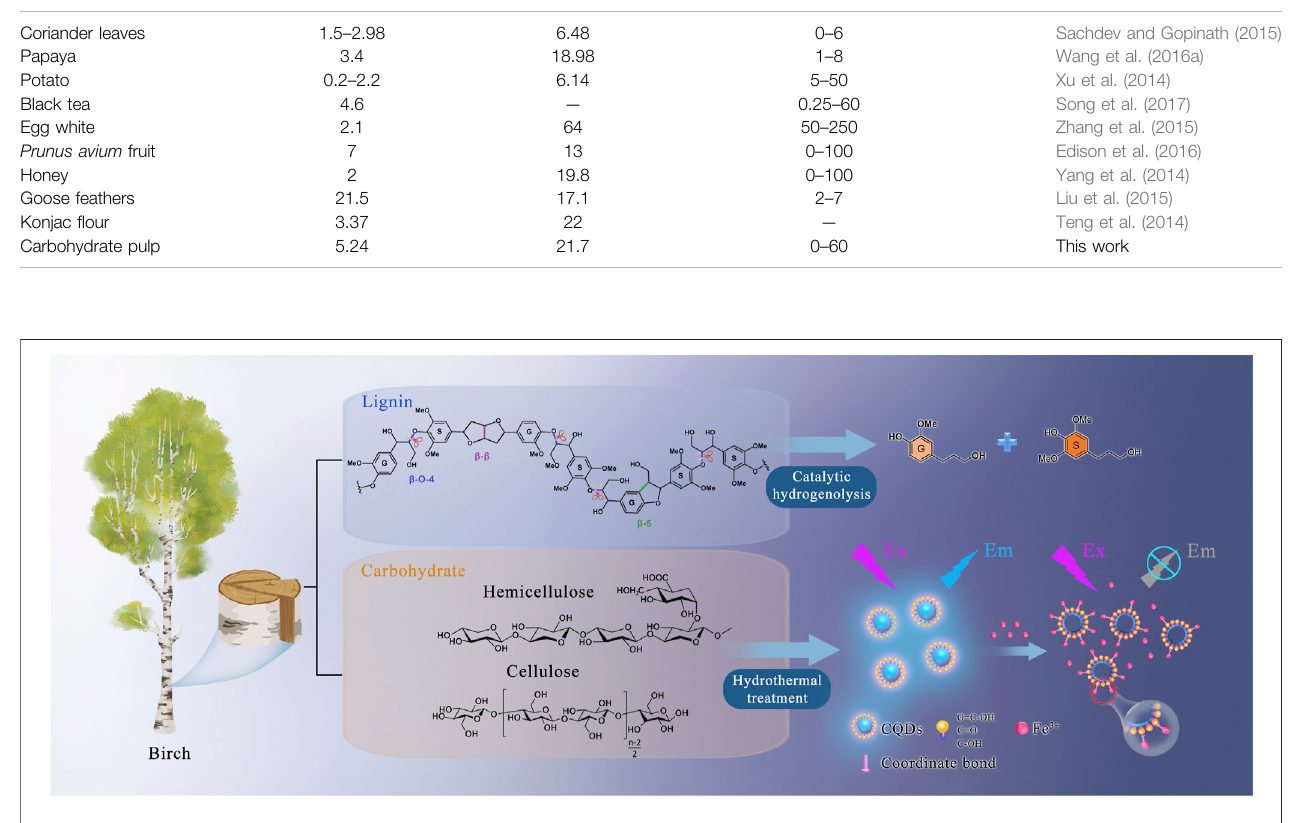
Frontiers in Bioengineering and Biotechnology |